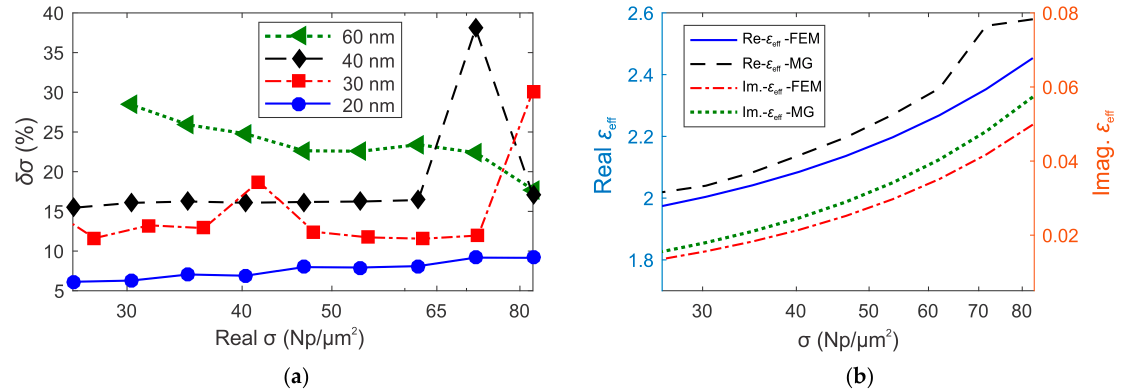
Figure 10 . ( a ) The relative deviation δσ between the real surface density σ FEM and the density σ MG calculated applying the MG formula to fit the resonance angle θ FEM . ( b ) Comparison between the effective permittivity of the Au/water composite layer calculated using the MG mixing formula (MG- ε eff ) and the correct real values obtained by FEM method (FEM- ε eff ). The comparison has been performed considering AuNPs with a diameter of 40 nm.